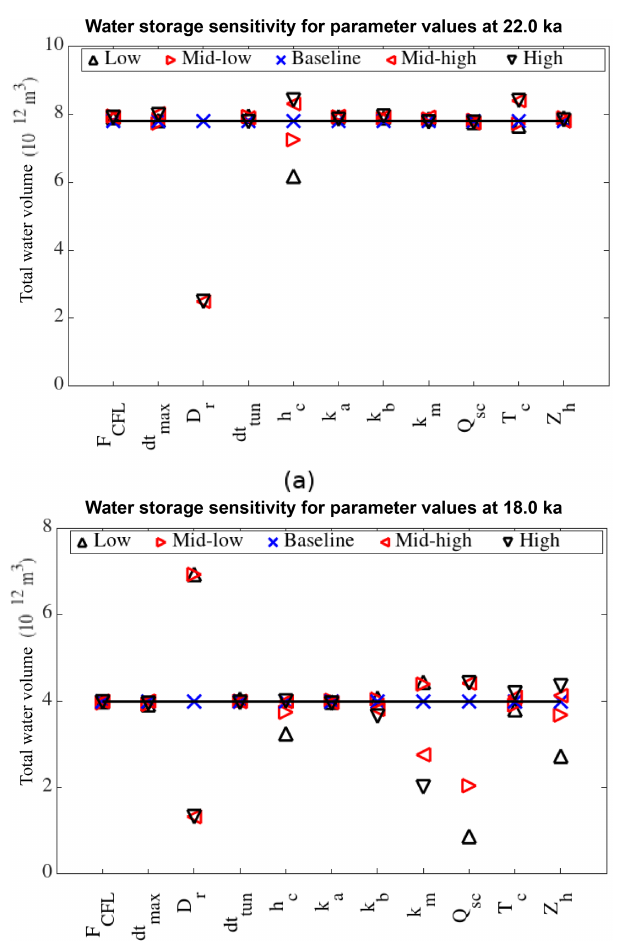
Figure 7. Sensitivity plot at (a) 22ka and (b)